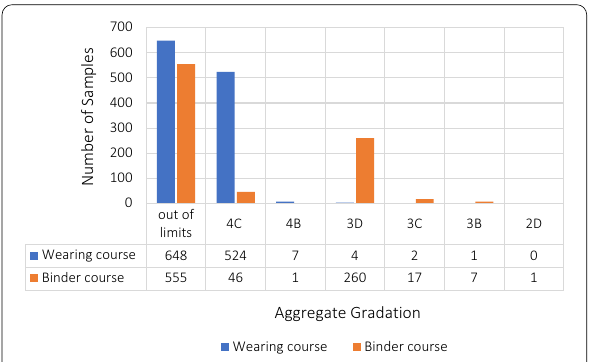
Fig. 1 Number of wearing course and binder course samples for different aggregate gradations